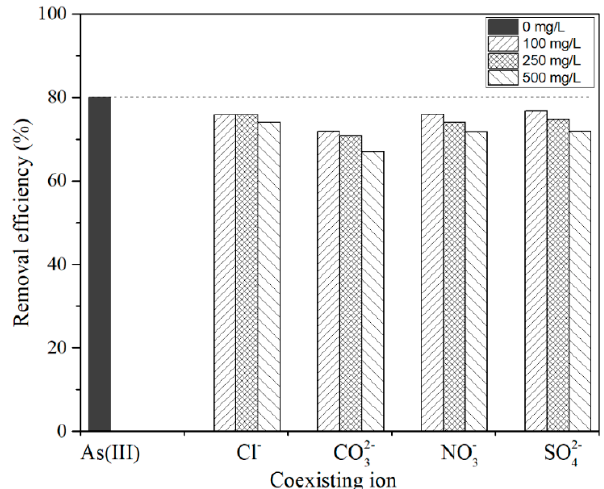
Figure 10. Effect of co-existing anions on As(III) removal by CTO nanoparticles (initial concentration − 1 , dose 1 g L − 1 , shaking 300 rpm for 2 h at room temperature and pH 15 mg L − 1 , dose 1 g L − 1 , shaking 300 rpm for 2 h at room temperature and pH 3). 15 mg L